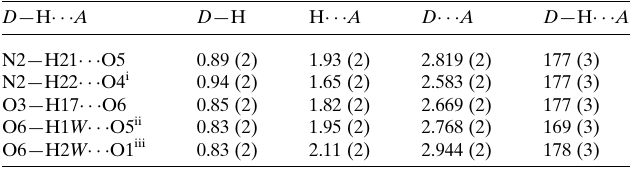
Table 4 Hydrogen-bond geometry (A˚ , (cid:5) ) for (IV). Cg 3 is the centroids of the C11–C16 ring.